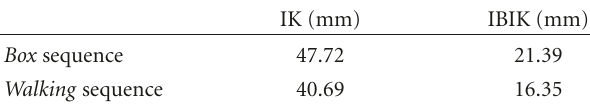
Table 2: Overall error of the estimation of the 3D positions of the internal joints for the two sequences (the elbow in the case of the arm and the knee in the case of the leg) for the two